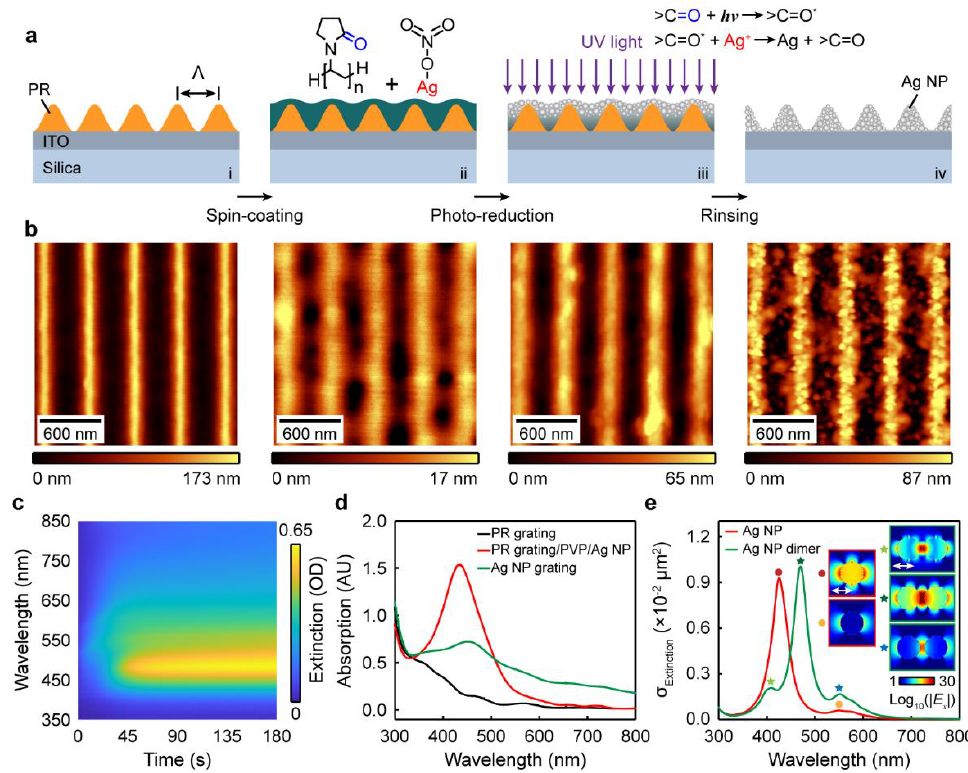
Figure 1. Patterning of Ag NP grating structure on an ITO waveguide. ( a ) Scheme for the fabrication process of the nanostructures. ( b ) AFM images of the grating structures in each fabrication steps. ( c ) Extinction spectra versus irradiation time of the sample measured during the photo-reduction process. ( d ) Absorption spectra of the PR grating in step i, the grating after photo-reduction in step iii, and the Ag NP grating in step iv. ( e ) Simulated extinction spectra of a single Ag NP and two coupled Ag NPs. Inset: electric field distributions of the plasmon resonances, white arrows denote the polarization direction of the incident light.